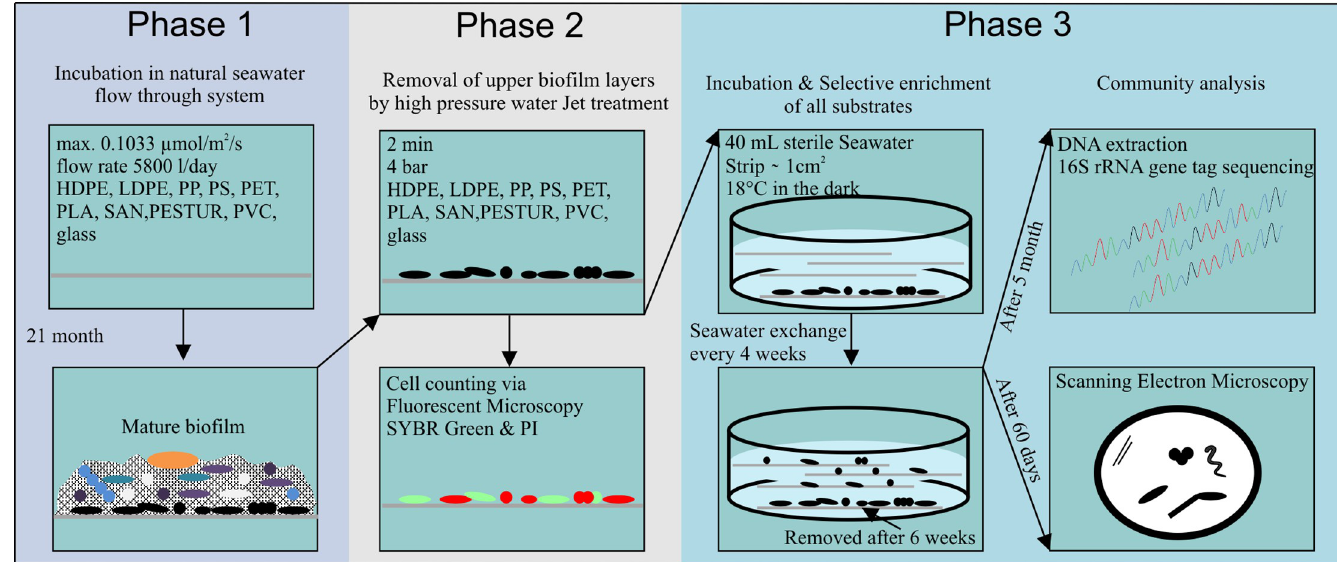
Fig 1. Experimental design. Schematic presentation of the three phased stepwise uncovering experiment of potential plastic “ specific ” bacteria.